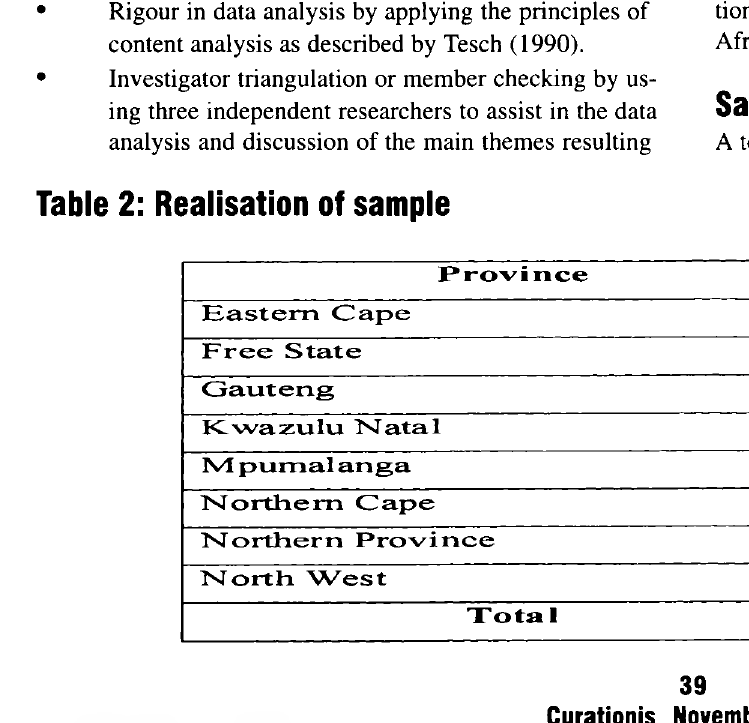
Table 2: Realisation of